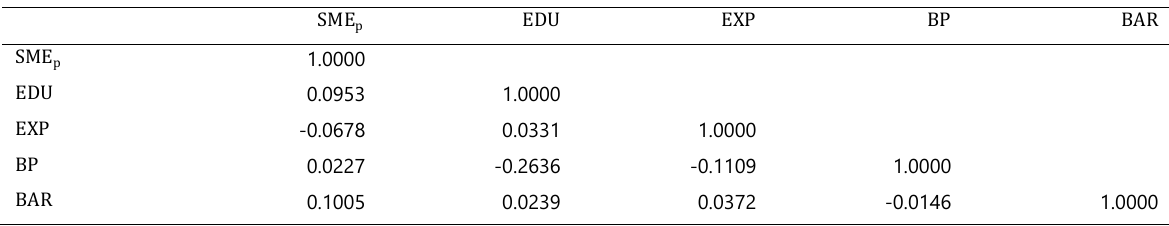
Table 2: Correlation Analysis (Source: Authors‟ calculation) SME p EDU EXP BP BAR SME p